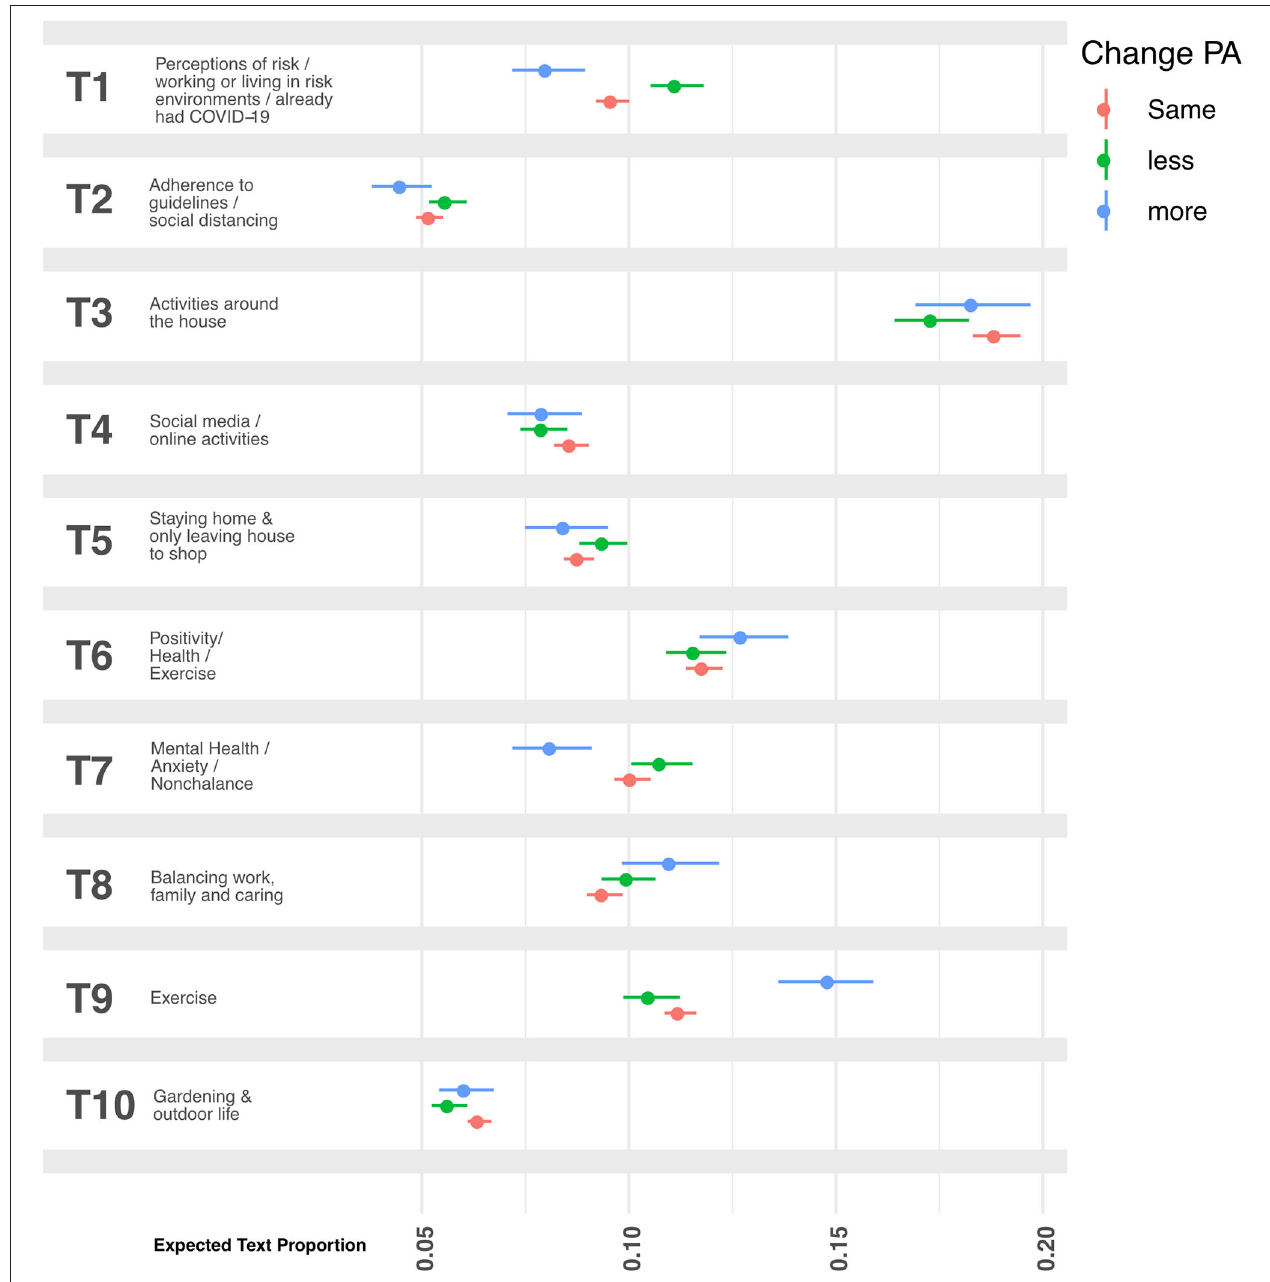
FIGURE 3 | Expected text proportions in open-ended narratives on participants’ coping behaviors. Participants were asked to describe their coping behaviors during the UK COVID-19 related lockdown. Perceptions of risk, working or living in risk environments, and already having had COVID-19 (topic T1) were mentioned in 9.7% (9.3–10.1%) of responses from participants who had not changed, in 8.1% (7.1–9.0%, p = 0.001) of responses from people doing more PA and in 11.2% (10.4–11.9%, p < 0.001) among participants doing less PA. Topic T3 ( p = 0.01) and T10 ( p = 0.006) had lower ETPs in the PA group doing “less”. Topics T7 and T8 had, respectively, lower ( p < 0.001) and higher ( p = 0.006) in the PA group doing “more”. Topic T9 “Exercise” was notably much higher in the group which reported doing more intense PA under lockdown ( p < 0.001). All analysis used the group which had not changed PA intensity as the